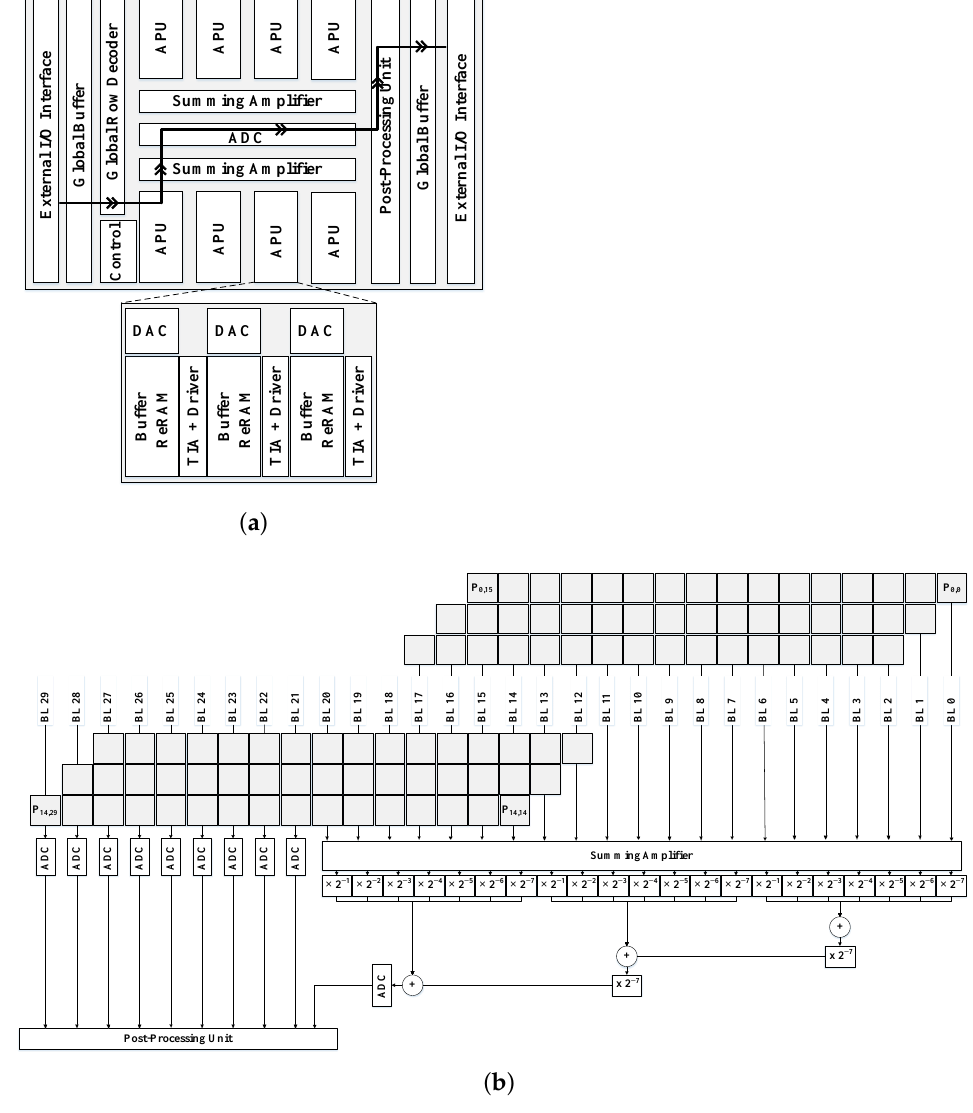
Figure 23. ( a ) Overview of the CASCADE architecture; and ( b ) final accumulation with a summing amplifier (adapted from